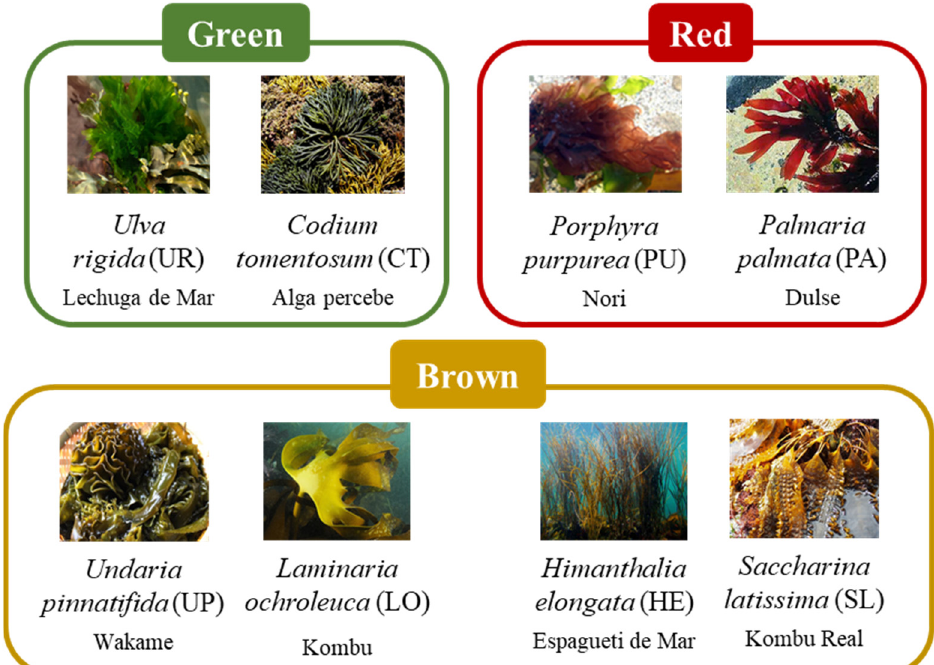
Figure 1. Seaweeds included in this study with their Spanish common names.